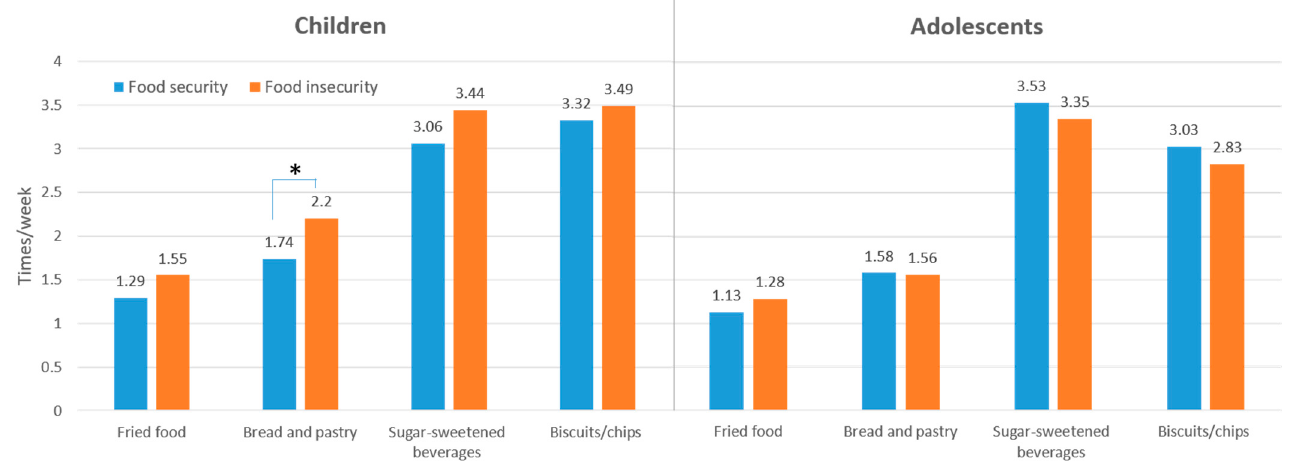
Figure 2. Frequency of unfavorable food intake for children and adolescents. * p < 0.05.